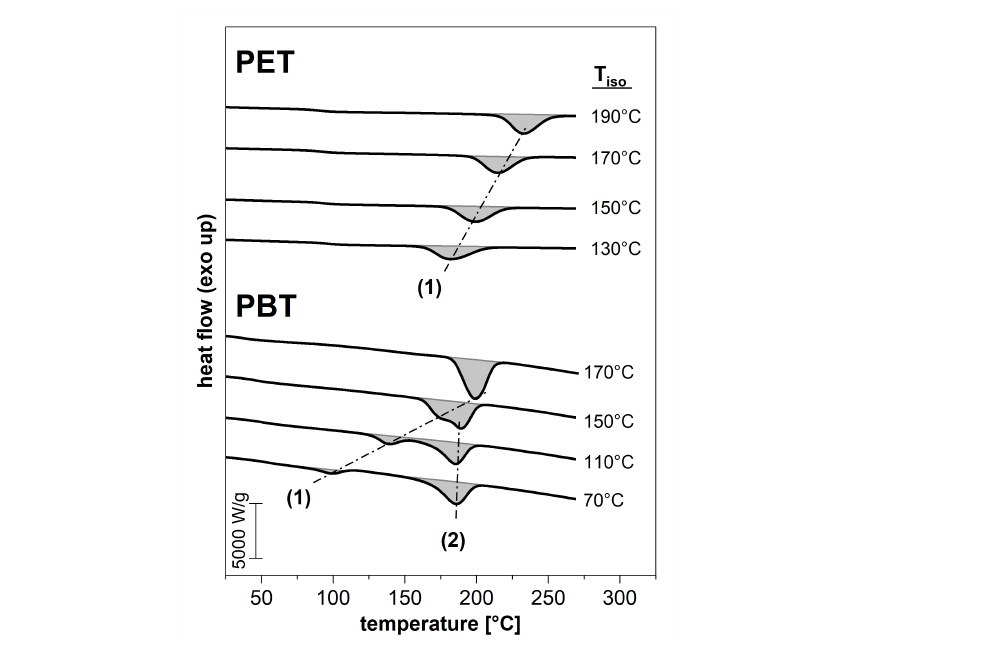
Figure 6. Exemplary first heating runs (at 1000 K/s) after the isothermal crystallization at T iso obtained with the